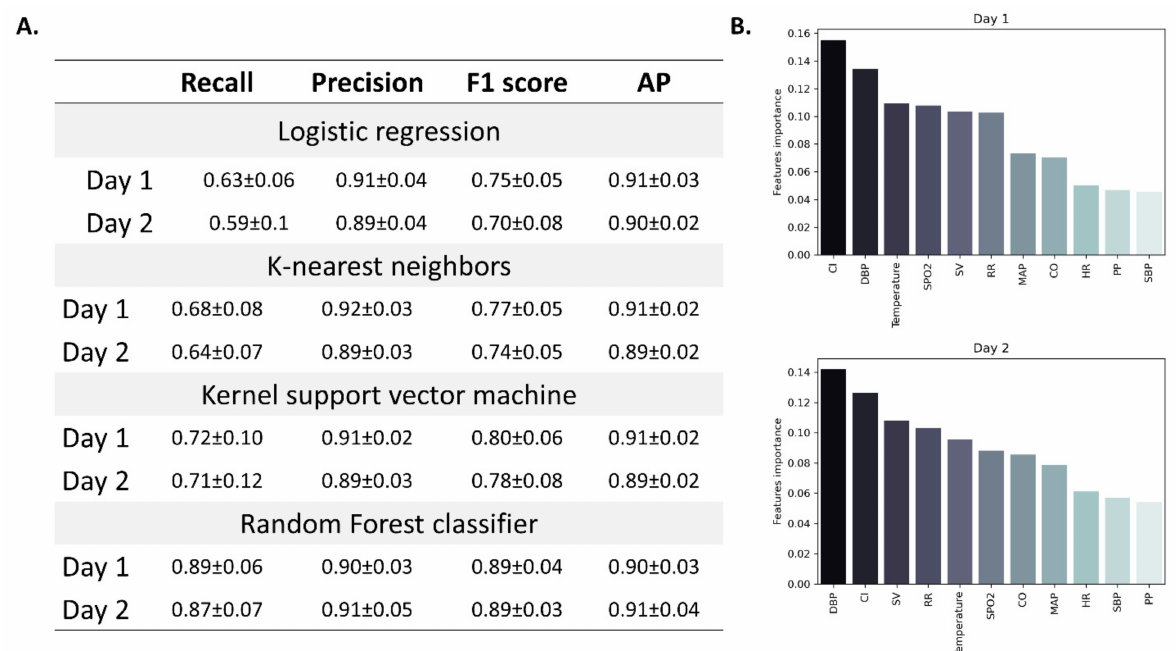
Figure 6. Classification models used for the prediction of viral infection based on changes in physiological parameters. Four models were tested for viral infection classification: logistic regression, k-nearest neighbors, kernel support vector machine, and random forest. Models’ performance was assessed using several metrices ( A ). Panel ( B ) features importance as calculated for the random forest model in days one and two before infection. Data are presented as mean ± standard deviation. DBP: diastolic blood pressure; CI: cardiac index; SV: stroke volume; RR: respiratory rate; SPO 2 : blood oxygen saturation; CO: cardiac output; MAP: mean arterial pressure; HR: heart rate; SBP: systolic blood pressure; PP: pulse